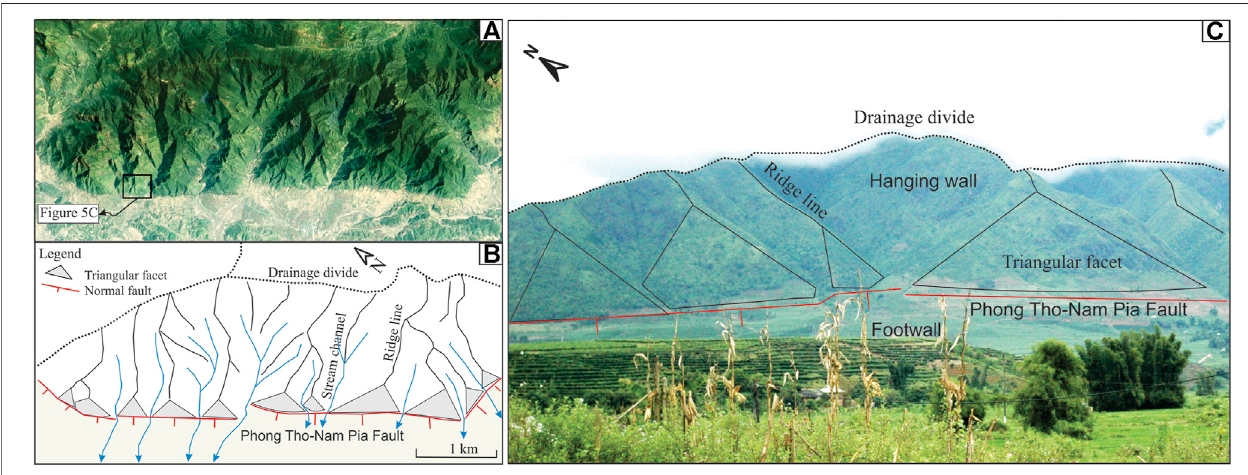
FIGURE 5 | (A, B) Satellite imagery (from Google Earth, December 18, 2019) and sketched map showing triangular facet pattern on the southwestern side of the Fasipan mountain range (see Figure 3 for location); (C) Field photograph showing geomorphic indicators of possible active normal fault along the Phong Tho-Nam Pia